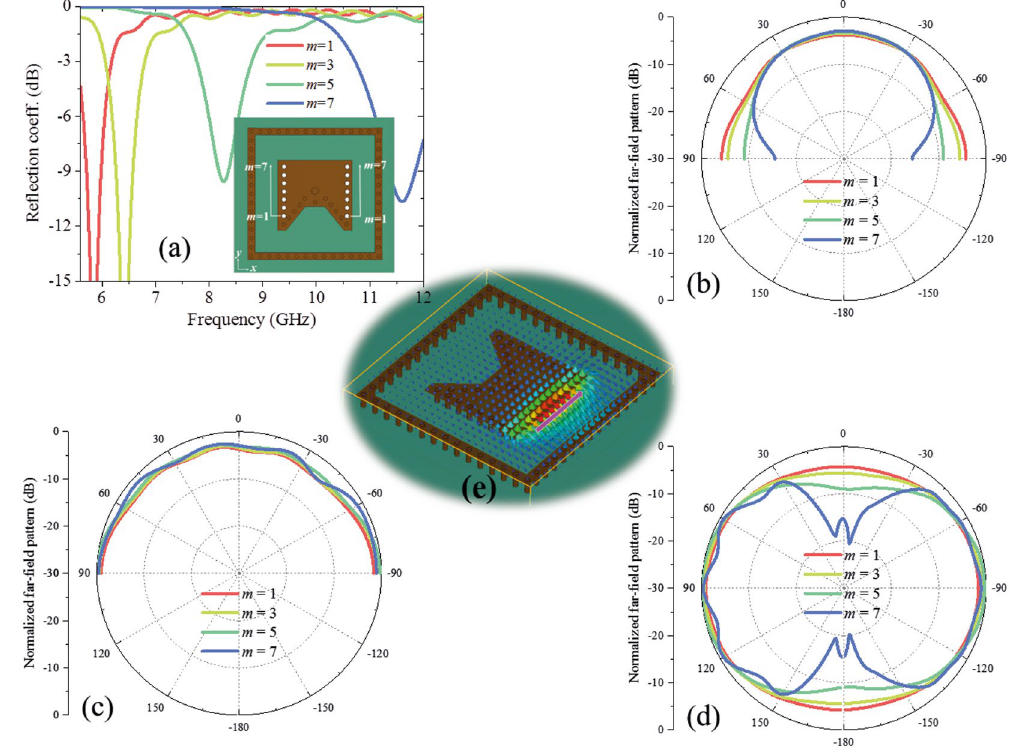
Figure 4. Relations between the number m of the additional grounded holes on two side edges and antenna performances. ( a ) Reflection coefficient versus number m . The insert figure shows the additional grounded holes discussed here, which are marked as white circles. These grounded holes are not used in the proposed antenna shown in Fig. 2, which is only used to show the operation principle of the structure. The distance of these holes are fixed and the same as the grounded hole on the short edge in Fig. 2. Normalized radiation patterns in xz plane, yz plane, and xy plane at 5.8 GHz versus number m are shown in ( b – d ), respectively. With the increasing of grounded holes, radiation on x-direction decreases. ( e ) Electric field distribution at 5.8 GHz in the case of m = 7. The equivalent magnetic current is marked in the figure. In the calculation, the ground is set as